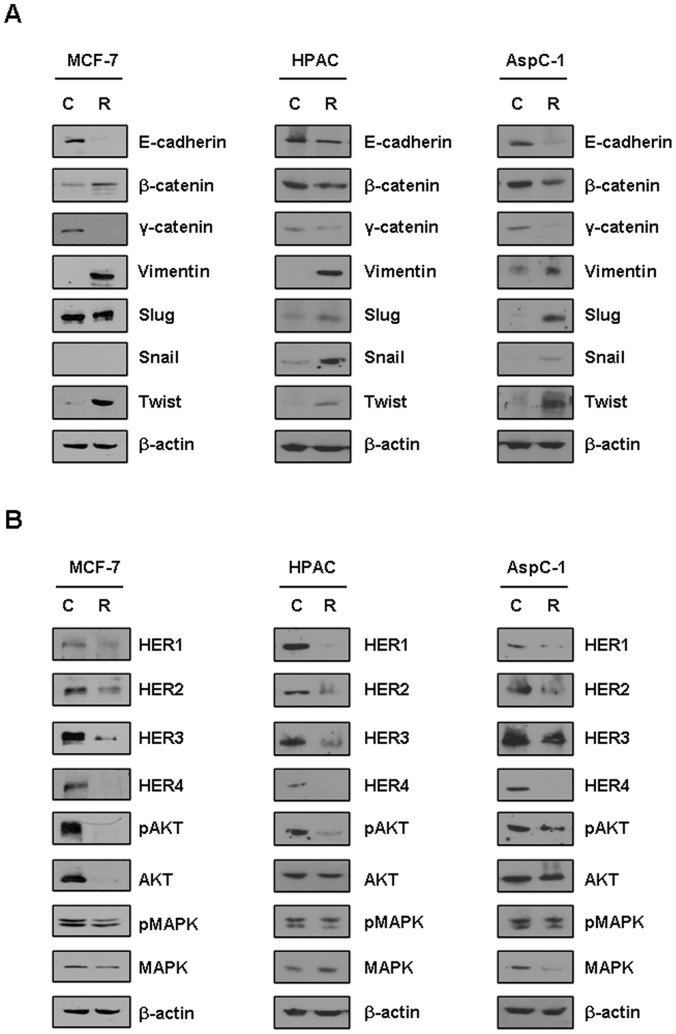
Acquired resistance to elisidepsin induces an EMT phenotype.A) Cells were lysed, proteins were extracted and western blots were performed with equal amounts of cell lysate (50 µg protein). Expression of epithelial (E-cadherin, β-catenin, γ-catenin)- and mesenchymal (vimentin, Slug, Snail, Twist)-associated proteins differentiates between elisidepsin-sensitive and elisidepsin-resistant cell lines. β-actin was used as an internal control. These western blots were performed in triplicate. B) Expression levels of HER1, HER2, HER3, HER4, pAkt, and pMAPK were analyzed by western blot using 50 µg of protein cell lysate. The membranes were stripped and reprobed with anti-β-actin to verify equal protein loading. C, control; R, resistance.